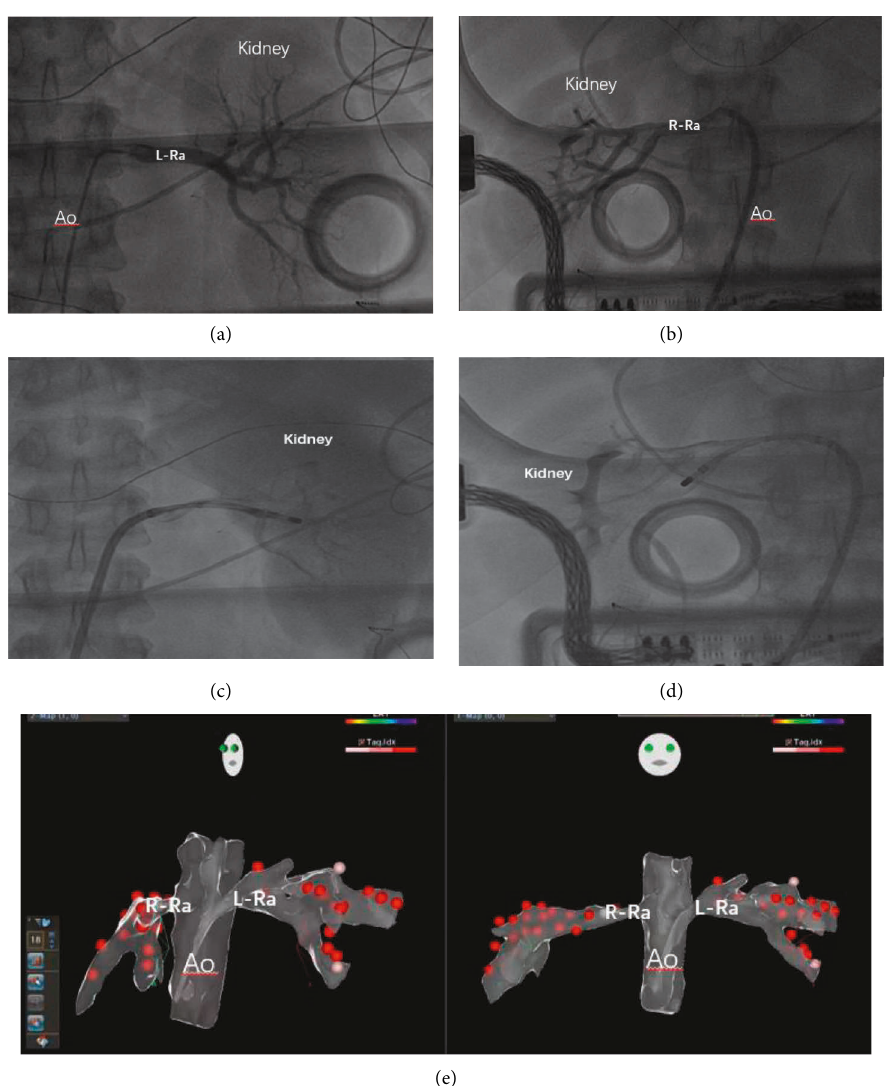
Figure 2: RDN operation. (a) Left renal arteriography; (b) right renal arteriography; (c, d) contact photoinduced pressure unipolar ablation catheter was delivered to the aorta and bilateral renal arteries; (e) three-dimensional map anatomy was established using the ensite system for point-by-point ablation in a four-quadrant spiral. The left picture shows the left-anterior oblique view, and the right one shows a-p position. L � left, R � right, RA � renal artery, and AO �